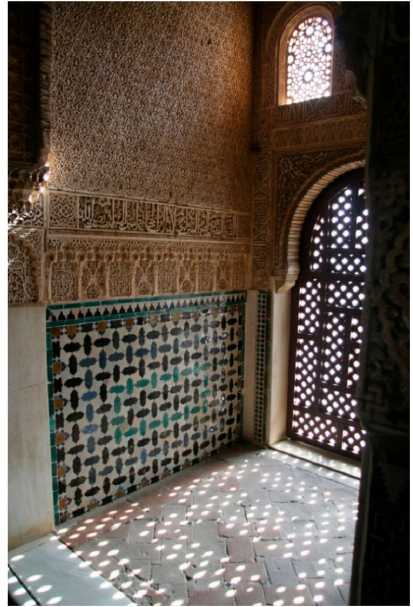
Figure 3. There were periods of architectural splendour manifest in the uniqueness of creations such as the Comares Hall. Detail of one of the alcoba (in the Andalusi architecture, this is a lateral room which is connected by an arch to the main hall) in the Comares Hall, completely covered by alicatados and plasterwork, 14th century. © Mar í a Elena D í ez Jorge,